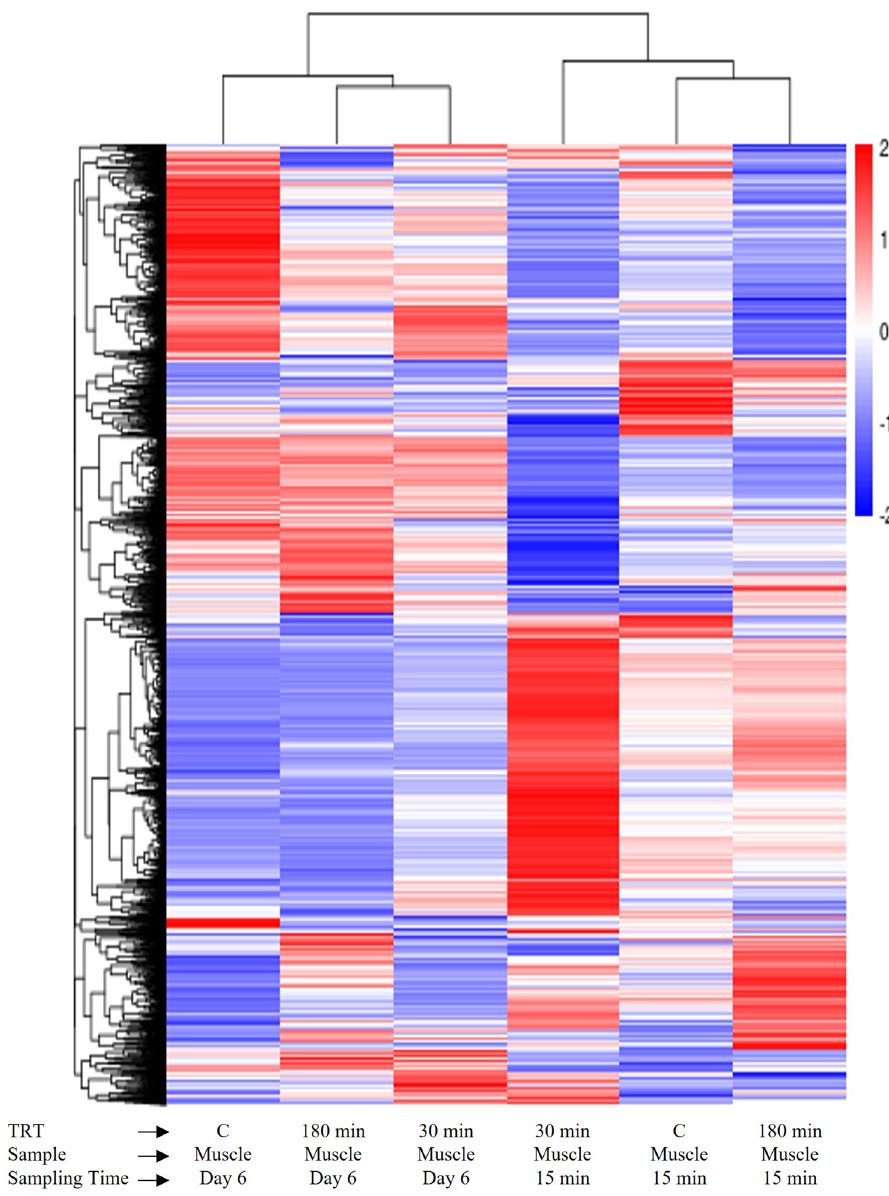
Figure 6. Heat map of meat samples ( Longissimus dorsi ) at 15 min postmortem or after 6 days from goats subjected to stress treatments (TRT: control, C = not transported but held in pens; 30 min = transported for 30 min; or 180 min = transported for 180